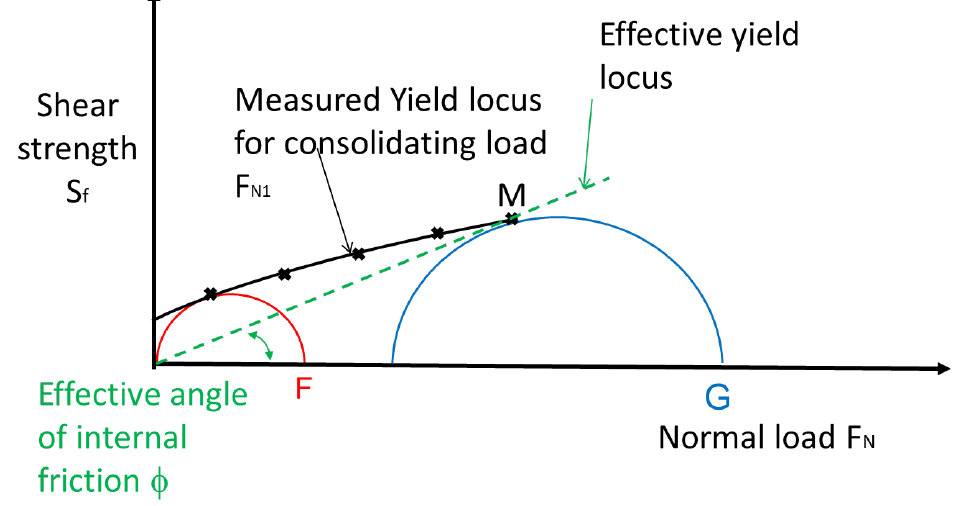
Figure 2. A typical yield locus obtained using a Jenike shear cell.